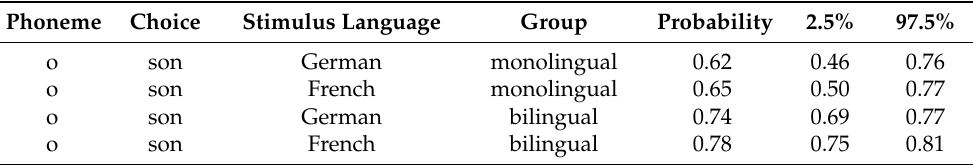
Table 9. Most probable responses given /o/ in French and German by L1 Spanish monolinguals and L1 Spanish bilinguals.